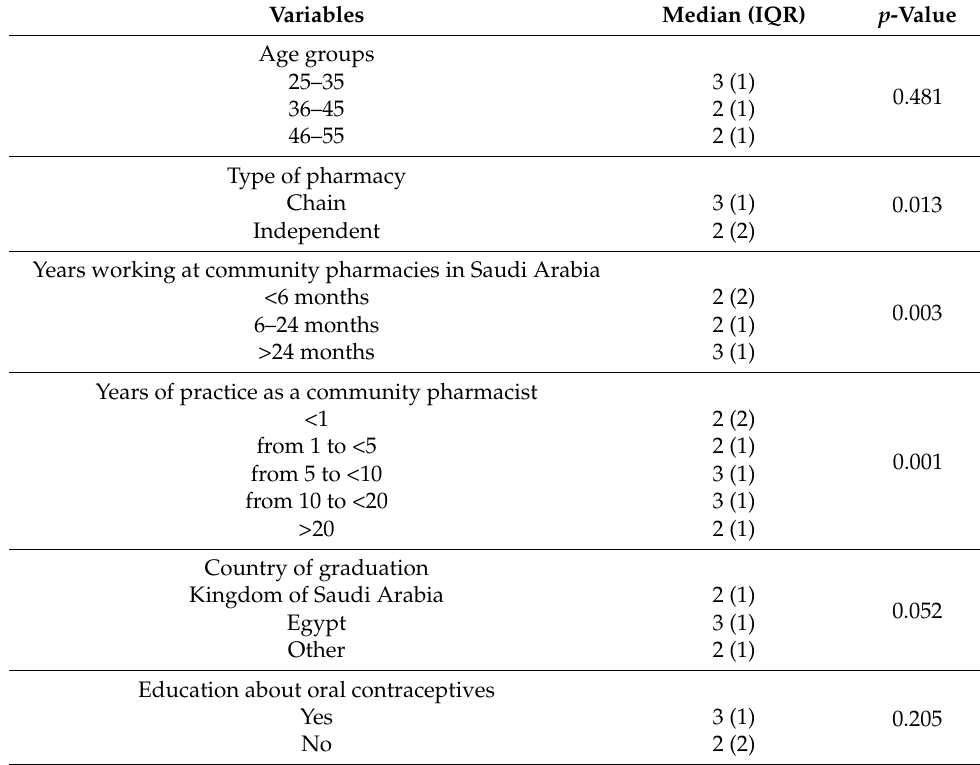
Table 4. Community pharmacists’ score of knowledge regarding proper use and missed